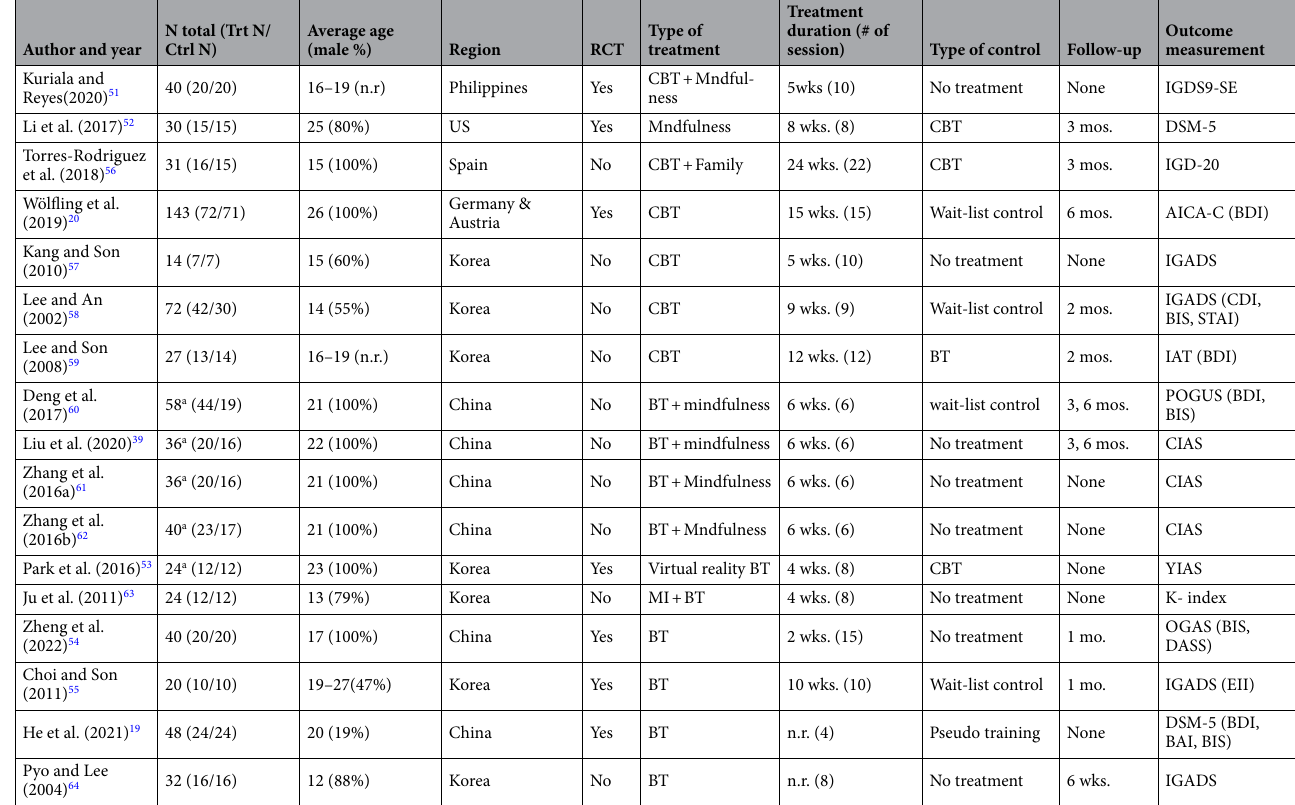
Table 1. Characteristics of included studies. AICA-C Assessment of Internet and Computer game Addiction Checklist, BAI Beck Anxiety Inventory, BDI Beck Depression Inventory, BIS Barratt Impulsiveness Scale,